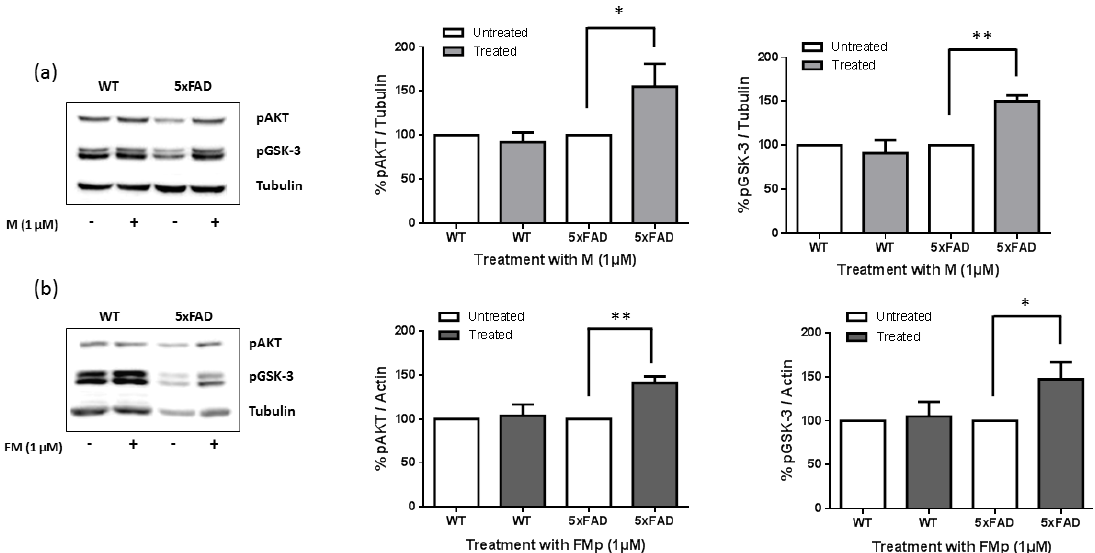
Figure 4. ITSCs derivatives reverse the inhibition of Akt and GSK-3 β phosphorylation in 5xFAD cells. Primary hippocampal cells isolated from wild type (WT) and 5xFAD mice were treated for 24 h with (1 μM) of M ( a ) and FMp ( b ). Equal amounts of total protein were analyzed on 10% SDS- PAGE gels and immunoblotted with primary antibodies against phosphorylated AKT and GSK-3 β kinases. Graphs depict densitometric quantification of phosphorylated proteins normalized to their housekeeping gene β -Tubulin or β -Actin. Results are expressed as the mean ± s.d. for at least three independent experiments and analyzed using a student t test (* p < 0.05, ** p < 0.01).